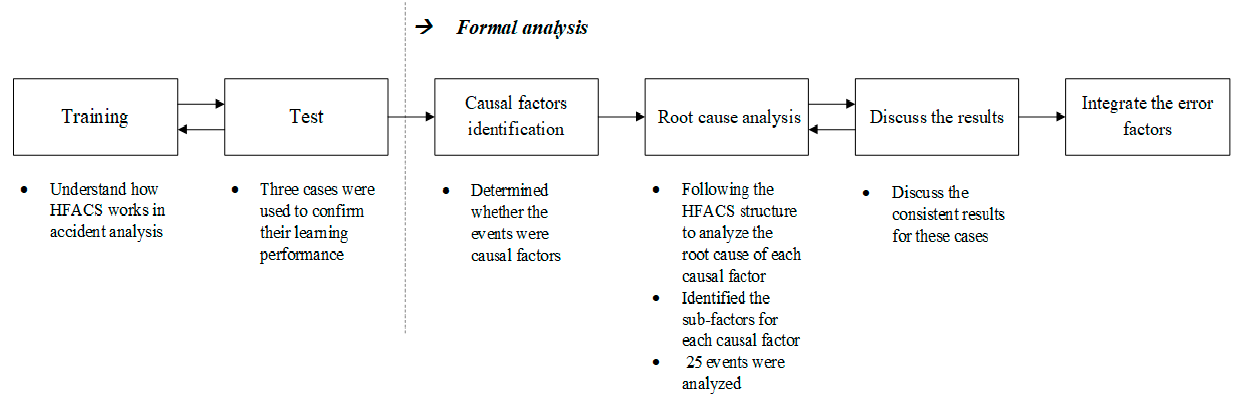
Figure 1. Process of error factor and subfactor analysis (Note: HFACS in this figure represent the Human Factors Analysis and Classification System).